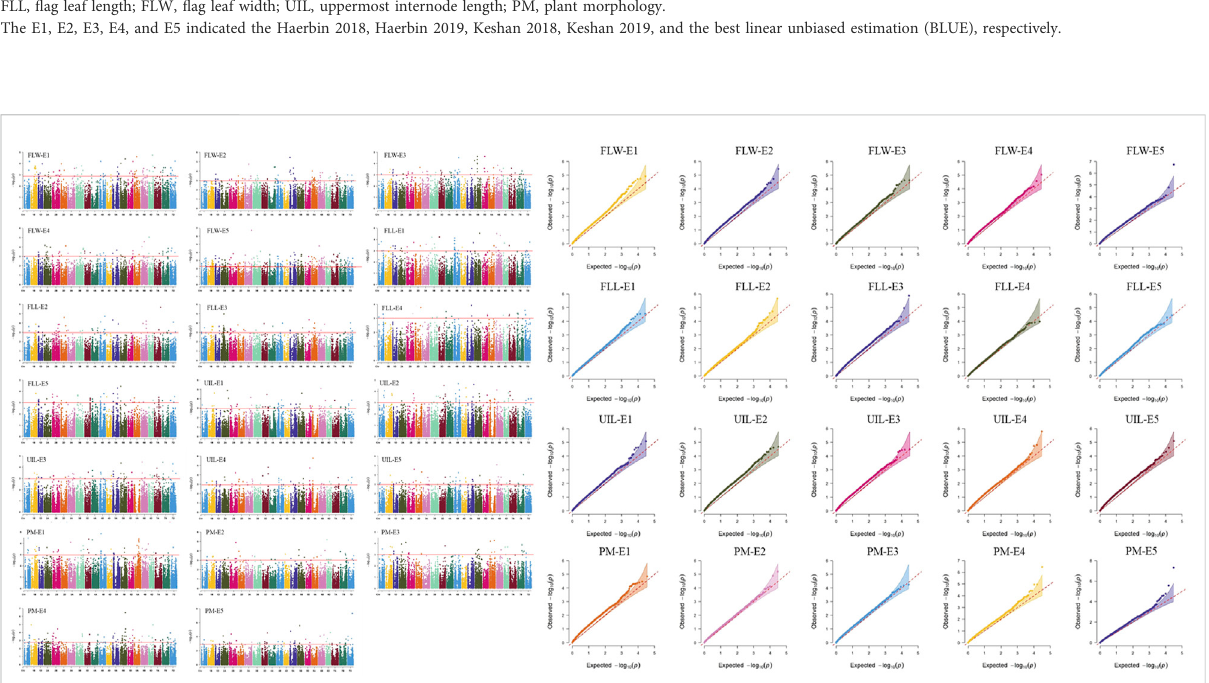
FIGURE 1 Manhattan and Q – Q plot for morphological traits in 251 spring wheat accessions from the Northeast of China analyzed by the mixed linear model (MLM) in Tassel v5.0. FLL, Flag leaf length; FLW, Flag leaf width; UIL, Uppermost internode length; PM, Plant morphology. The 1, 2, 3, 4, and 5 indicated the Harbin 2018, Harbin 2019, Keshan 2018, Keshan 2019, and the best linear unbiased estimation (BLUE), respectively.